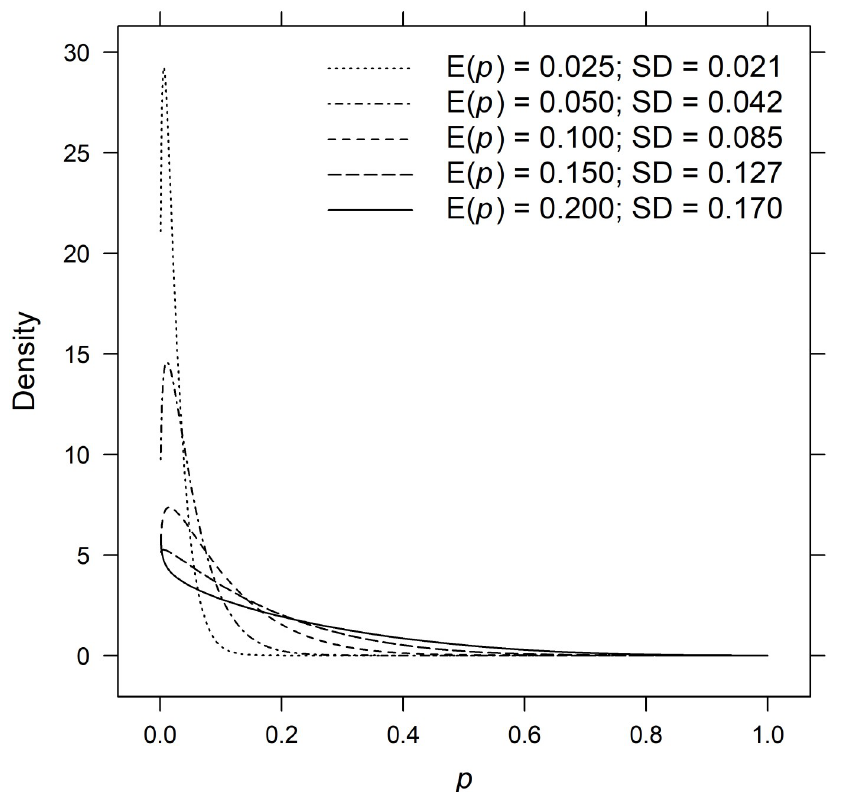
Fig 1. Beta densities for encounter probabilities. Beta densities for list-wise encounter probabilities from data- generating models M